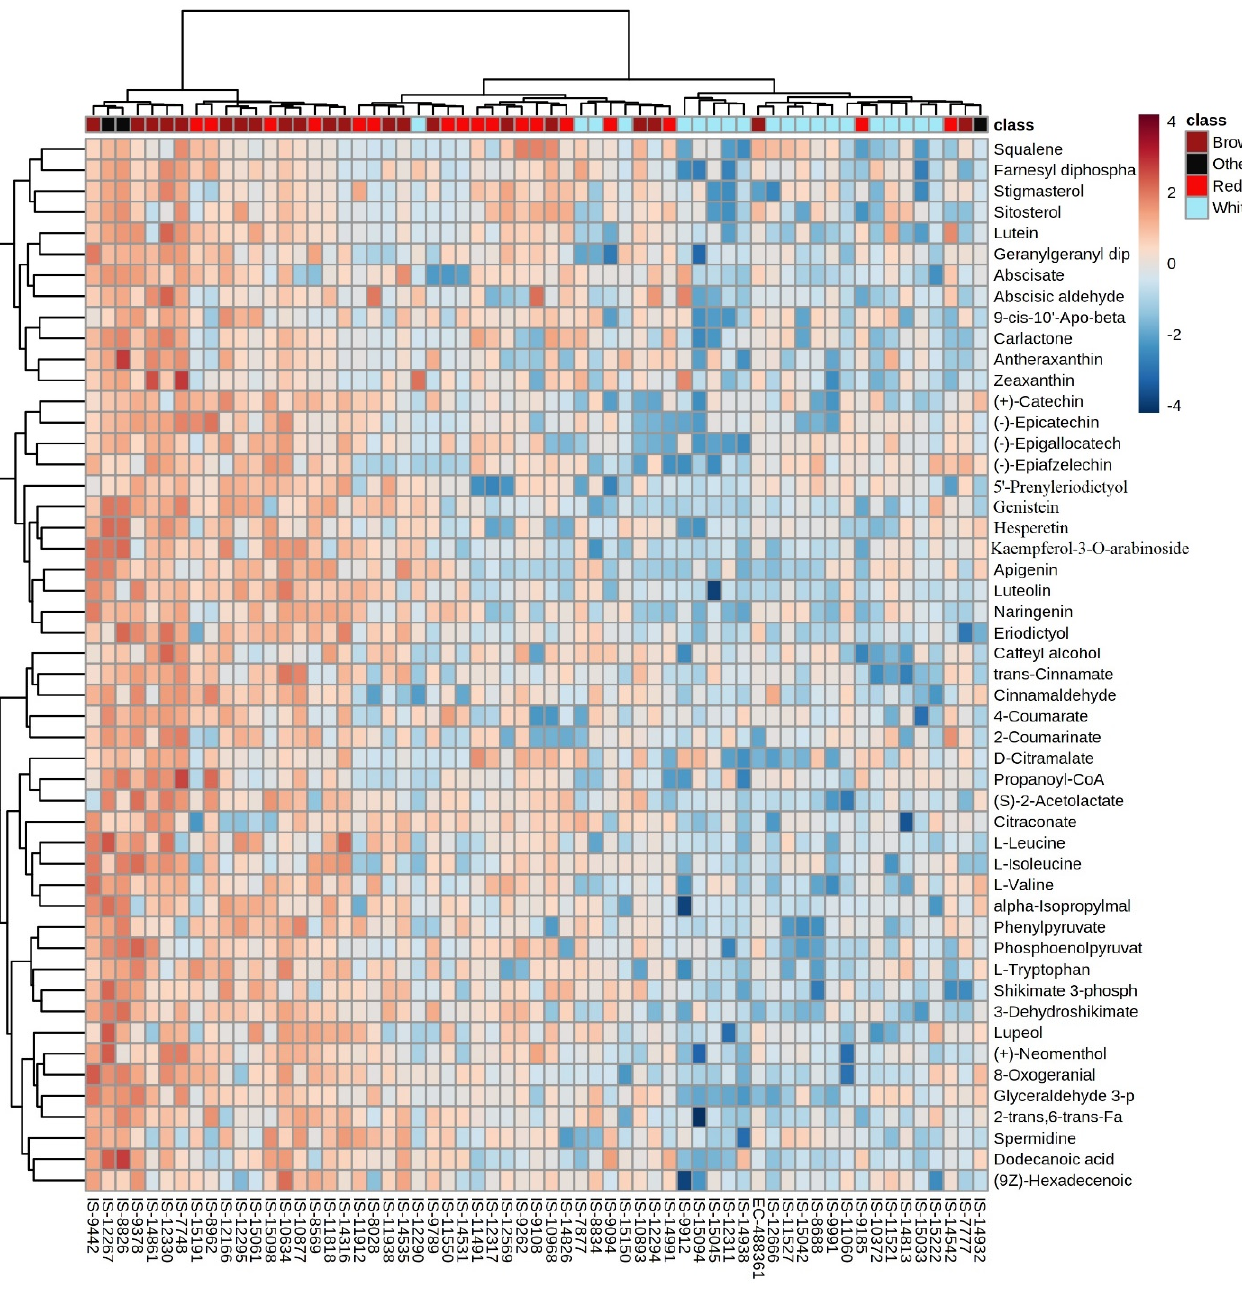
Figure 9. Sixty-one sorghum genotypes were clustered based on the accumulation pattern of 50 metabolites identified based on VIP scores from PLS-DA model. Color of the cell indicated the relative abundance of metabolites as indicated in the side color scale. Columns represent genotypes and rows represent a metabolite. Color of cells in the header row indicates the grain color category.